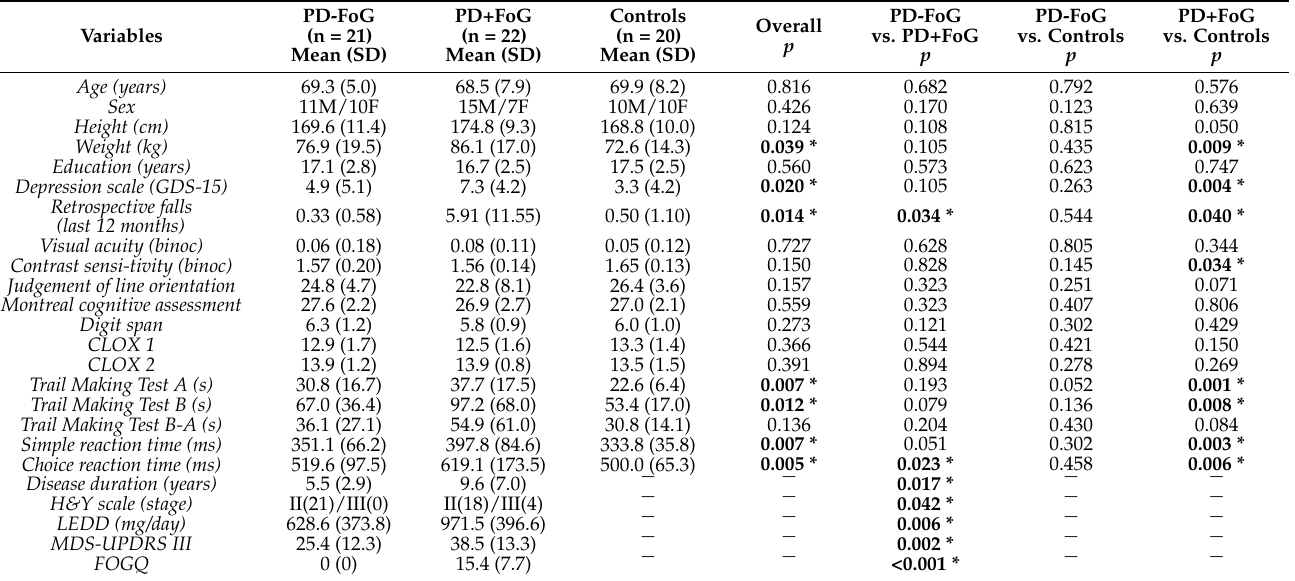
Table 1. Participant